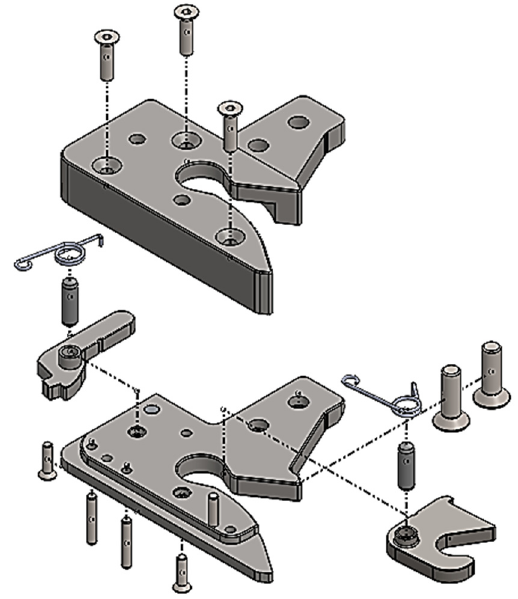
Figure 16. Gripper mechanism’s exploded view.